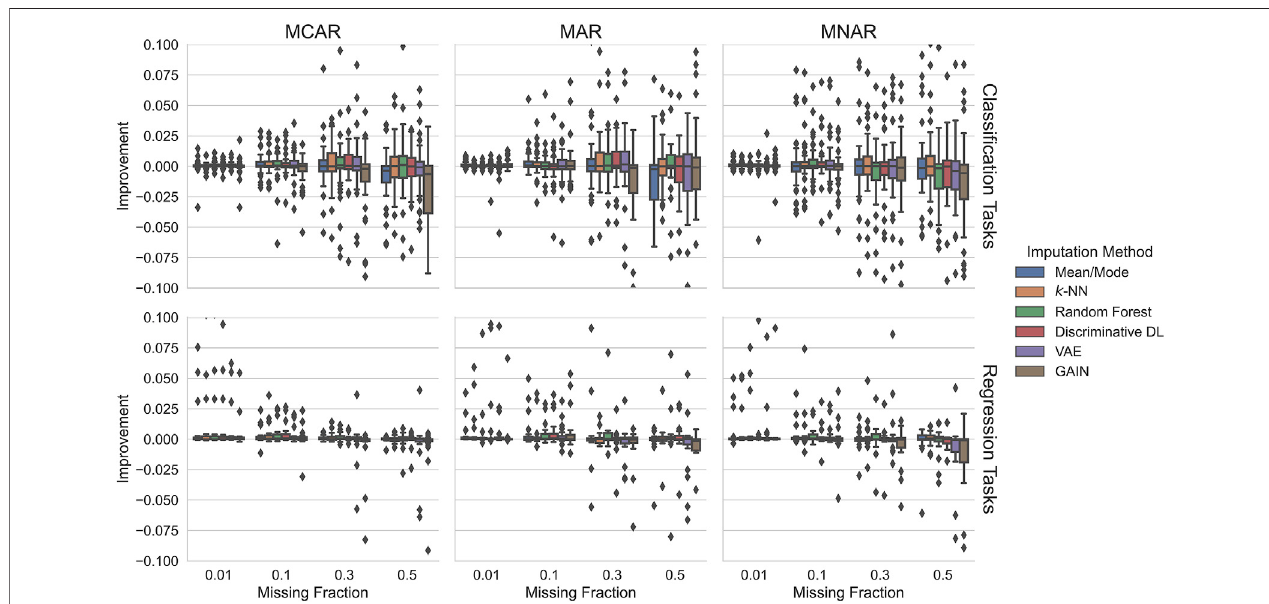
FIGURE 4 | Impact on the downstream task of the six imputation methods trained on incomplete data. In regression tasks, no considerable improvements are achieved. In some cases, imputation worsened the downstream ML model. In classi fi cation tasks, in contrast, we observe slightly positive effects in some settings, but negative effects predominate in the harder